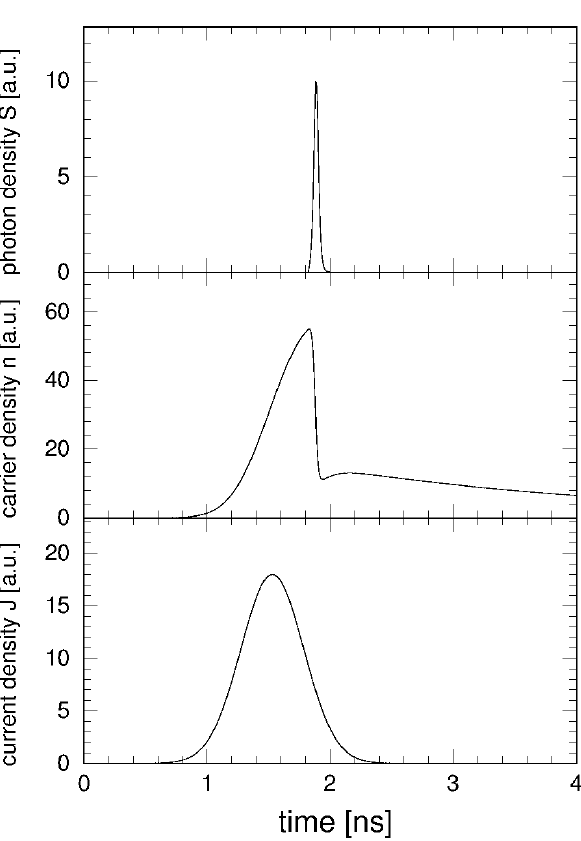
Fig. 2. Simulation of LD emission, similar to Figure 1. An electric pulse with 600 picoseconds in FWHM is applied. The pulse height is adjusted to induce the laser pulse after the peak of the electric